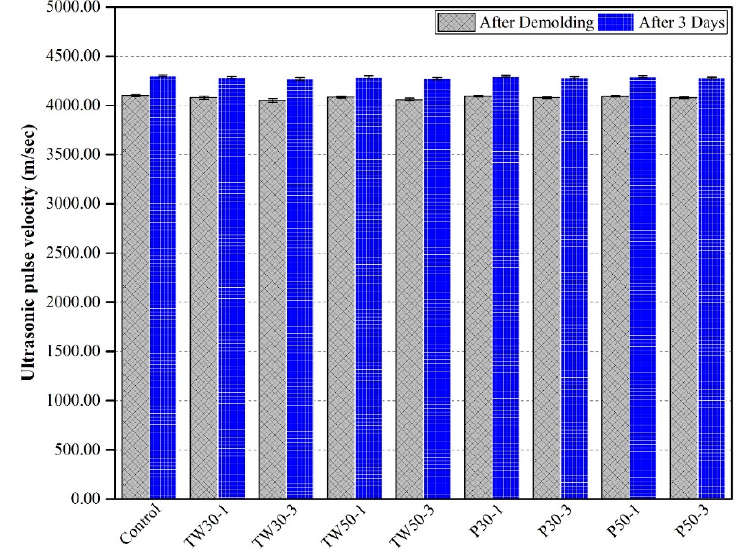
Figure 10. Ultrasonic pulse velocities of specimens.